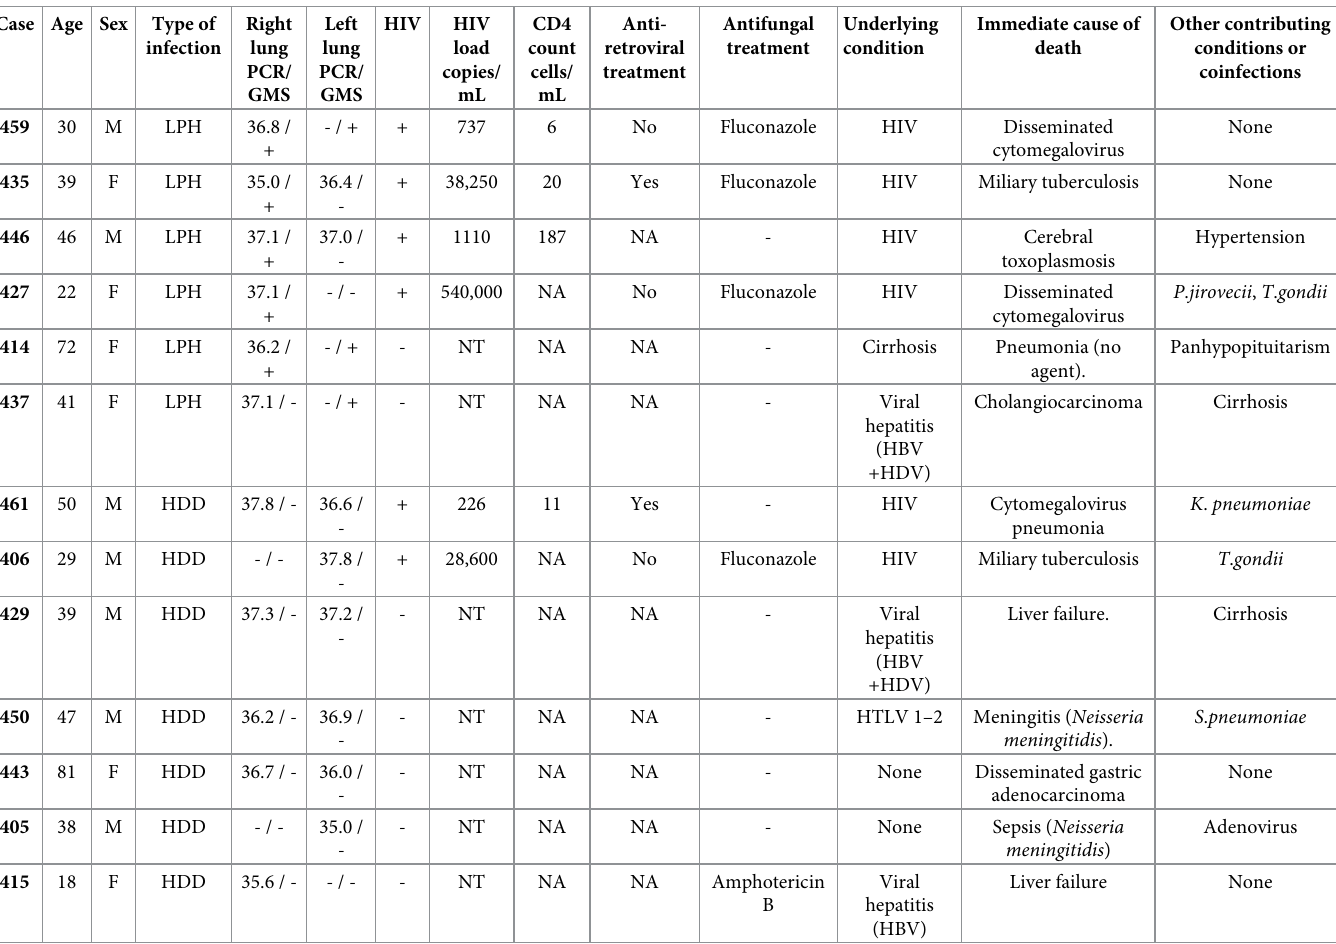
Table 3. Demographical, clinical characteristics, prophylactic treatment, results of the real-time PCR for Histoplasma and the Grocott-Gomori metenamine silver (GMS) stain in the lungs of patients with localized pulmonary histoplasmosis (LPH) and patients with Histoplasma DNA detection (HDD) in the lungs without his- tological